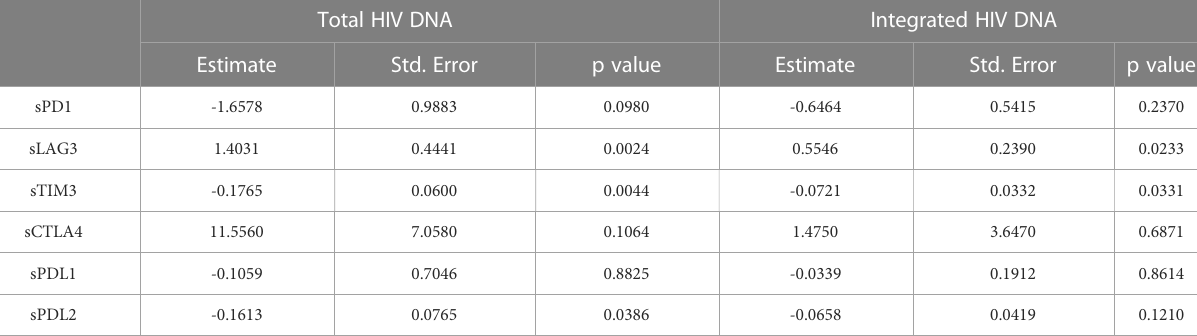
TABLE 2 Relationship between reservoir size and soluble immune checkpoint proteins in participants on antiretroviral